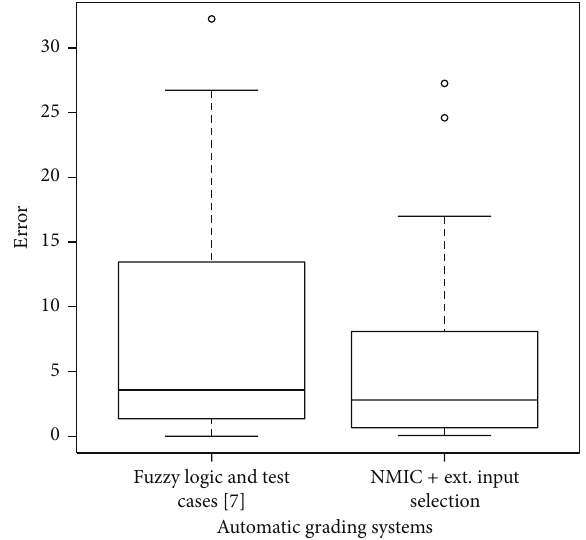
Figure 5: Boxplot comparing the test results (10-cv) of two different automatic grading systems: Fuzzy Logic and Test Cases [7], and NMIC + Extended Input Selection (this paper), showing a statisti- cally relevant difference between both